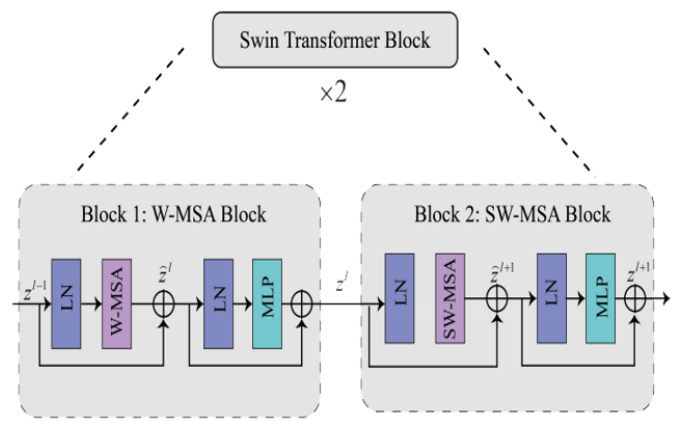
Figure 6. Swin Transformer Block structure.